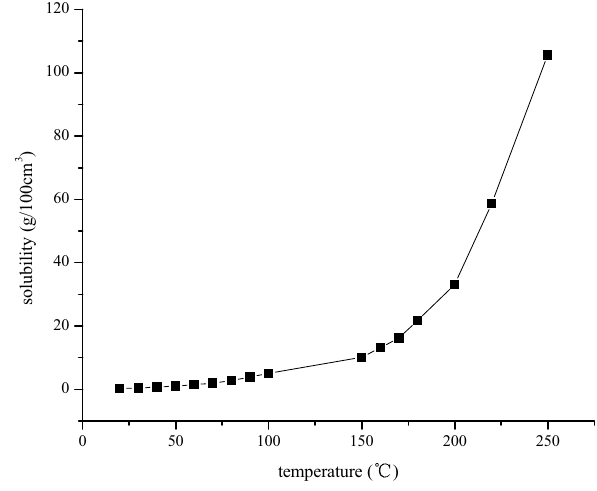
Fig. 2 Solubility of MA at various temperatures Fig. 3 Contact angles after cores being soaked for 15